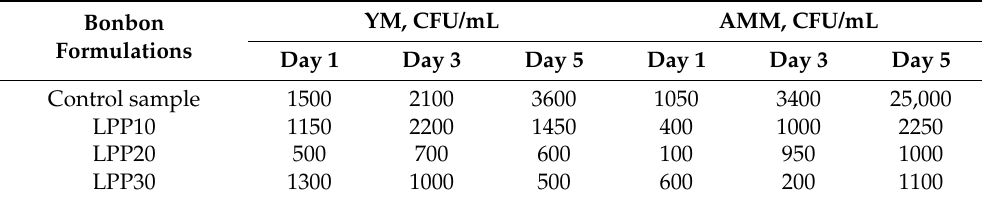
Table 8. Microbial count of bonbon formulations: YM—yeasts and molds; AMM—aerobic mesophilic microorganisms.